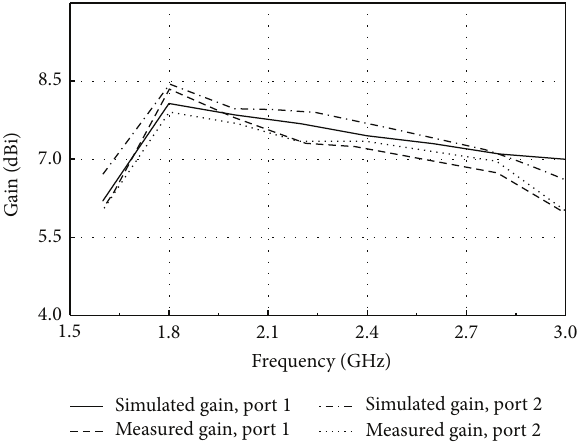
Figure 8: Simulated and measured gains at the two ports. ports, the gains at the two ports increase sharply and the peak gains are achieved at about 1.8 GHz at both ports, where the good impedance matchings are obtained for both ports, as shown in Figure 6. The measured gain varies among the range of 6 − 8 dBi within the operating